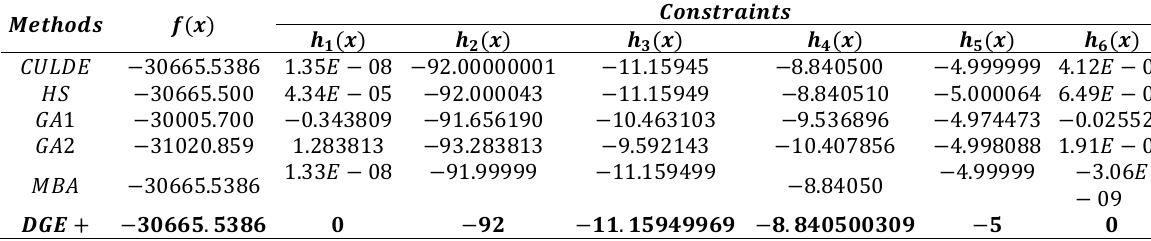
Table 14. Reported results for constrained problem 7 from different optimizers